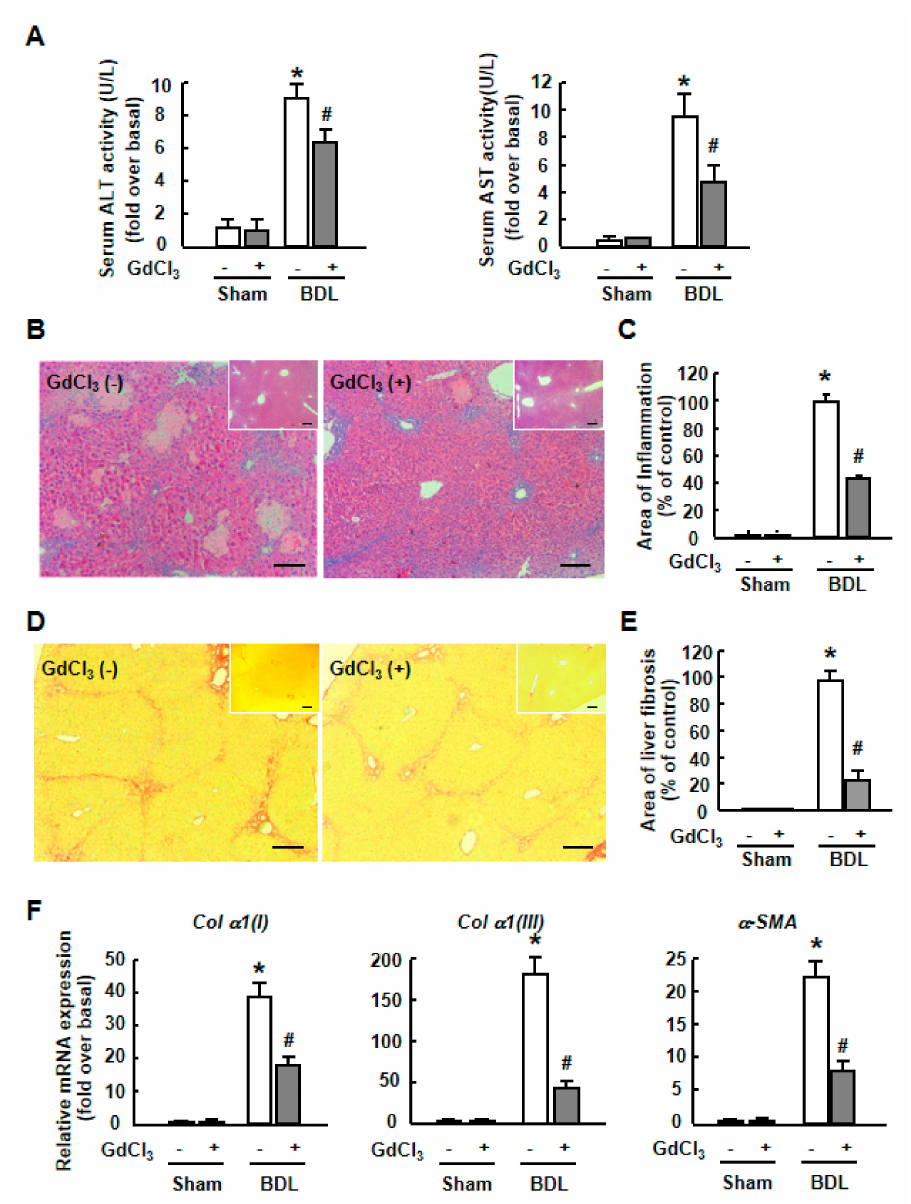
Figure 7. The e ff ect of GdCl 3 on liver inflammation and fibrosis in BDL mouse models. ( A ) Serum ALT and AST activity in BDL mice with or without GdCl 3 administration. ( B ) Representative H&E-staining liver sections after GdCl 3 administration in BDL liver. Scale bars, 50 µ m. Inset: H&E-staining for Sham livers. ( C ) Quantification of inflammatory areas. ( D ) Representative images of Sirius Red staining after GdCl 3 administration in BDL liver. Scale bars, 50 µ m. Inset: Sirius Red staining for Sham